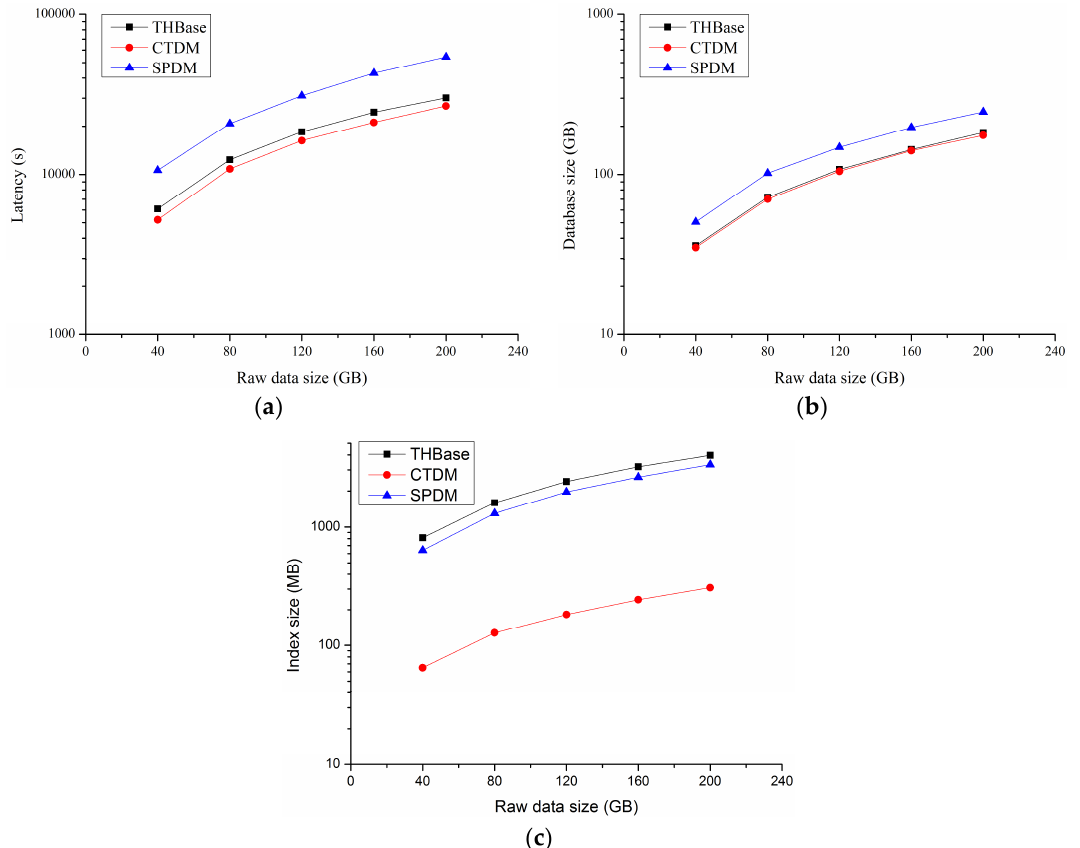
Figure 4. Time and storage cost for inserting data: ( a ) time cost, ( b ) database cost, ( c ) index cost.